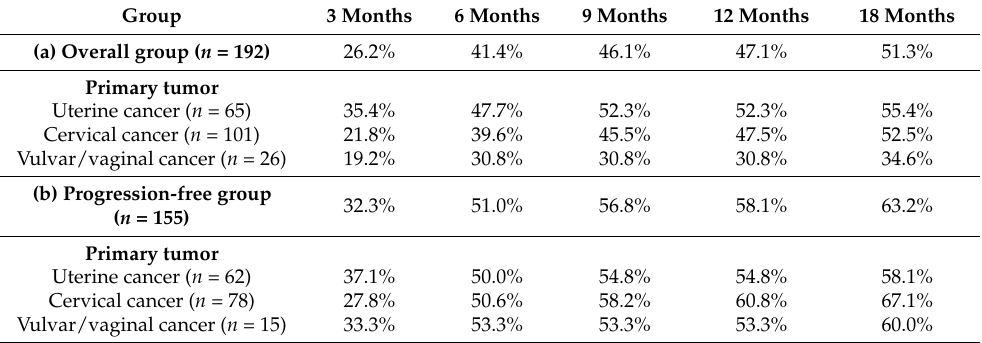
Figure 1. Return to work rates for the overall group in Kaplan-Meier estimates (one minus survival) depending on oncologic progression ( A ), the presence of acute fatigue during radiotherapy ( B ), the presence of depression ( C ), and body mass index (BMI) ( D ). Table 2. Return to work